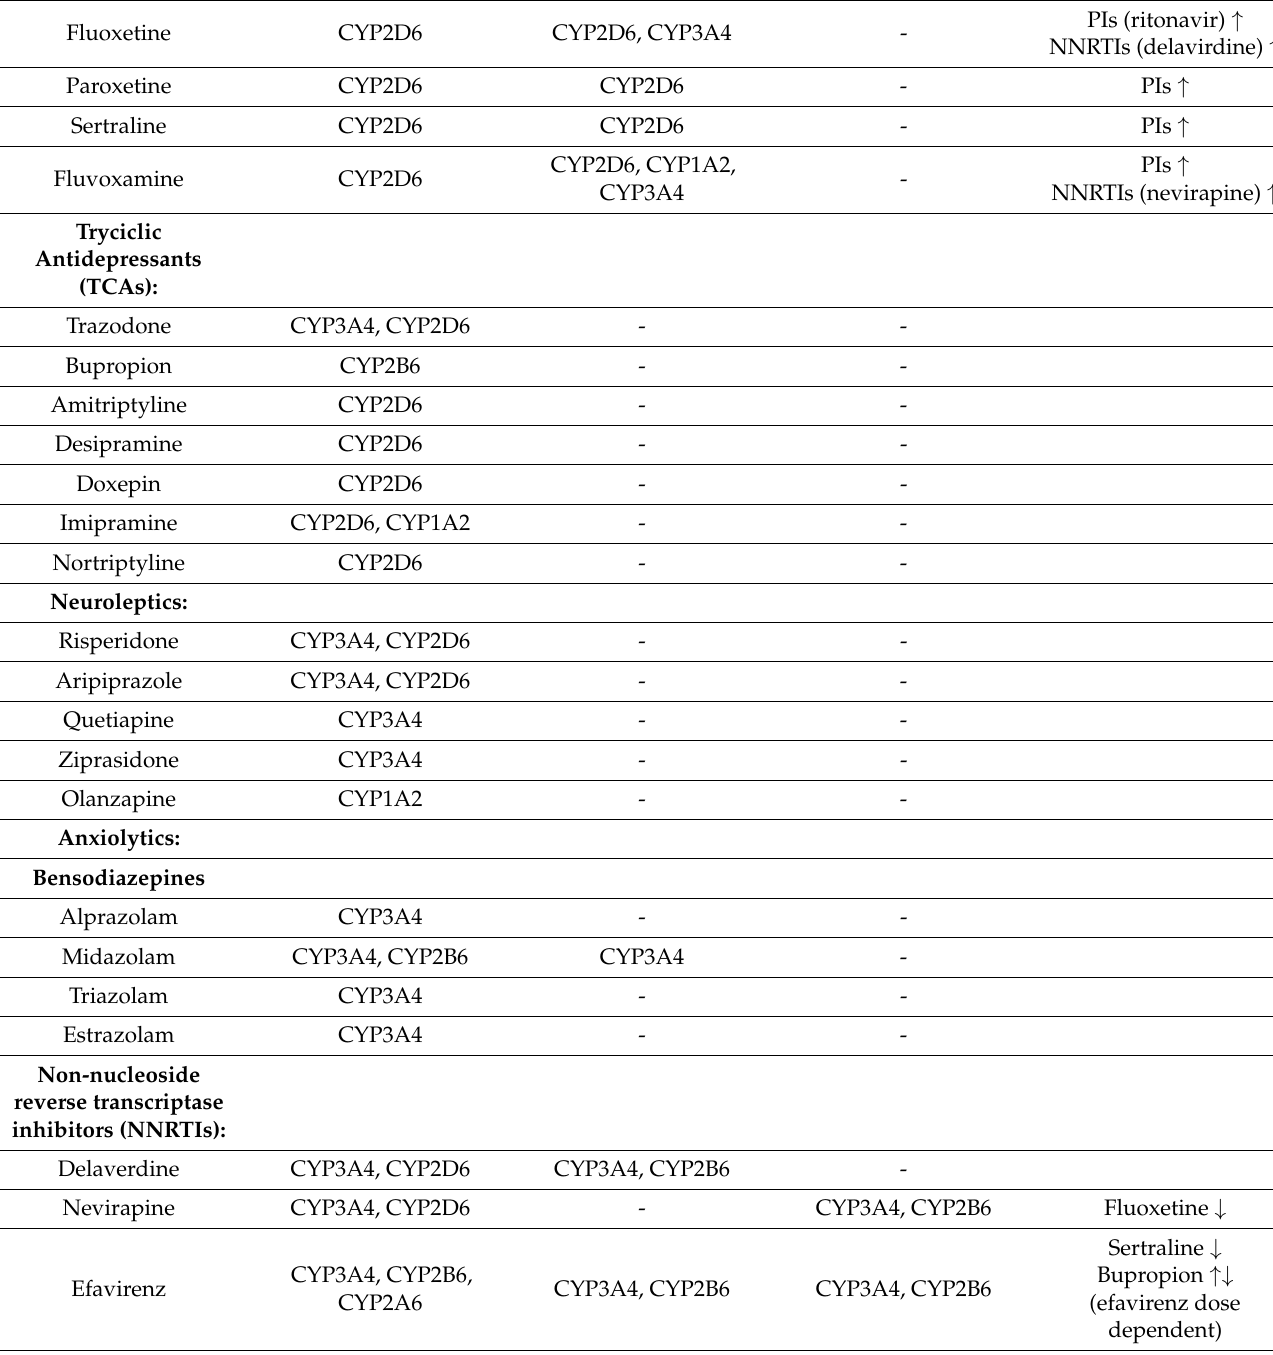
Table 2. Psychotropic and antiretroviral drugs interactions mediated by P450 metabolism. P450 Cytochrome Inhibitor Inducer Drug Substrate